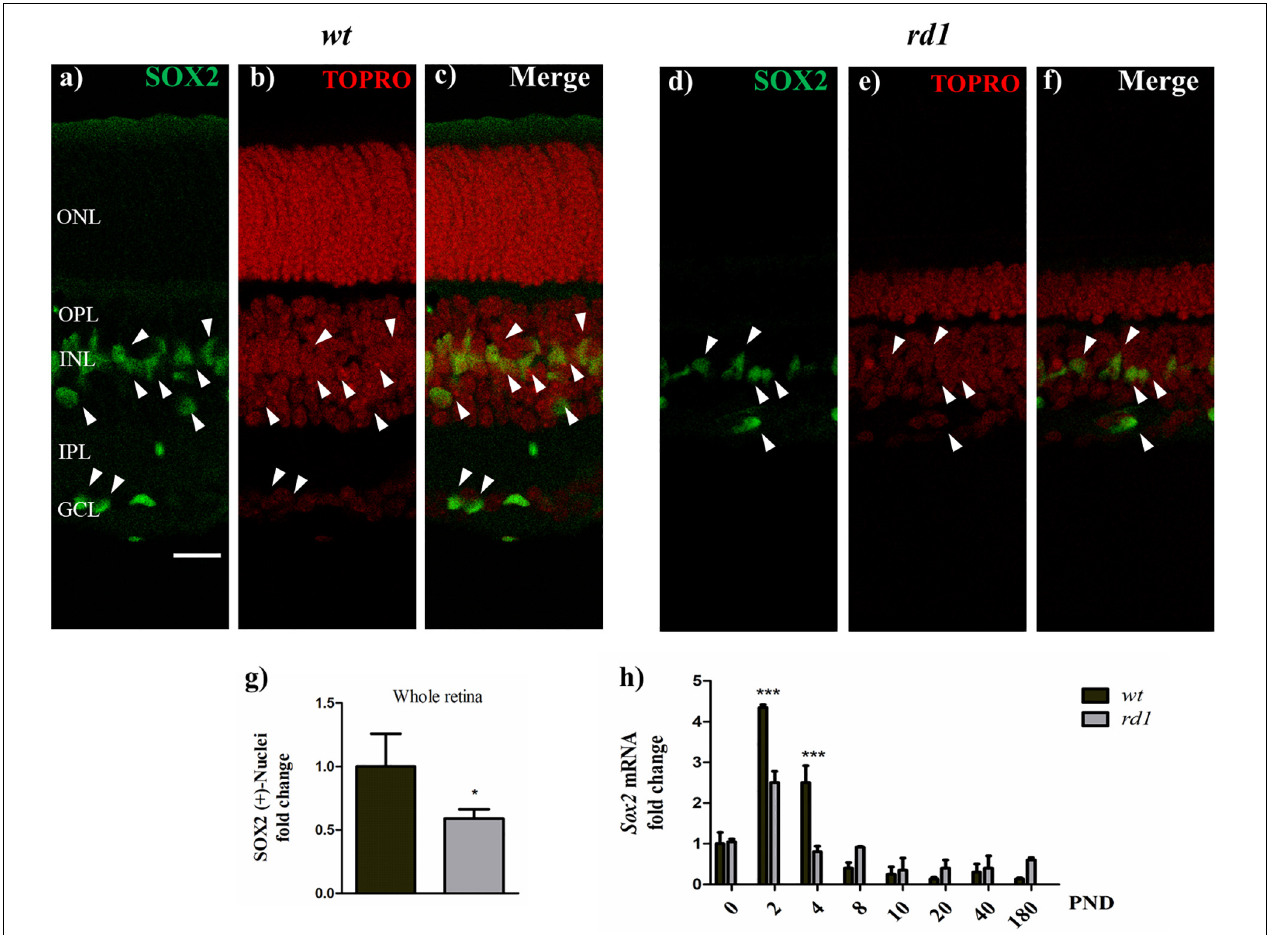
FIGURE 5 | SOX2 expression decreased in rd1 retinas. Fluorescence photomicrographs show SOX2 expression ( a,d , arrowheads) in retina cryosections obtained from wt (a–c) and rd1 (d–f) mice at PND14, determined with an anti-SOX2 polyclonal antibody. Nuclei were stained with DAPI (b,e) and merge pictures are shown in (c,f) . Bars (g) show the fold change of total SOX2-positive nuclei in rd1 retinas relative to wt retinas. Bars (h) represent the fold changes in Sox2 mRNA levels at PND 0-180 in rd1 and wt mice retinas relative to their levels at PND 0 in wt retinas. Scale bar: 20 µ m. Results in (g) represent the mean ± SEM of ten measures. Results in (h) represent the mean ± SEM of three mice per condition. Statistical analysis was performed using a two-tailed Student t -test (g) , and a One-way ANOVA with a post hoc Tukey test (h) . ∗ p < 0.05, ∗∗∗ p <